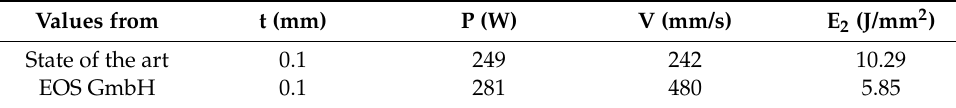
Table 4. Values of process parameters approximation.